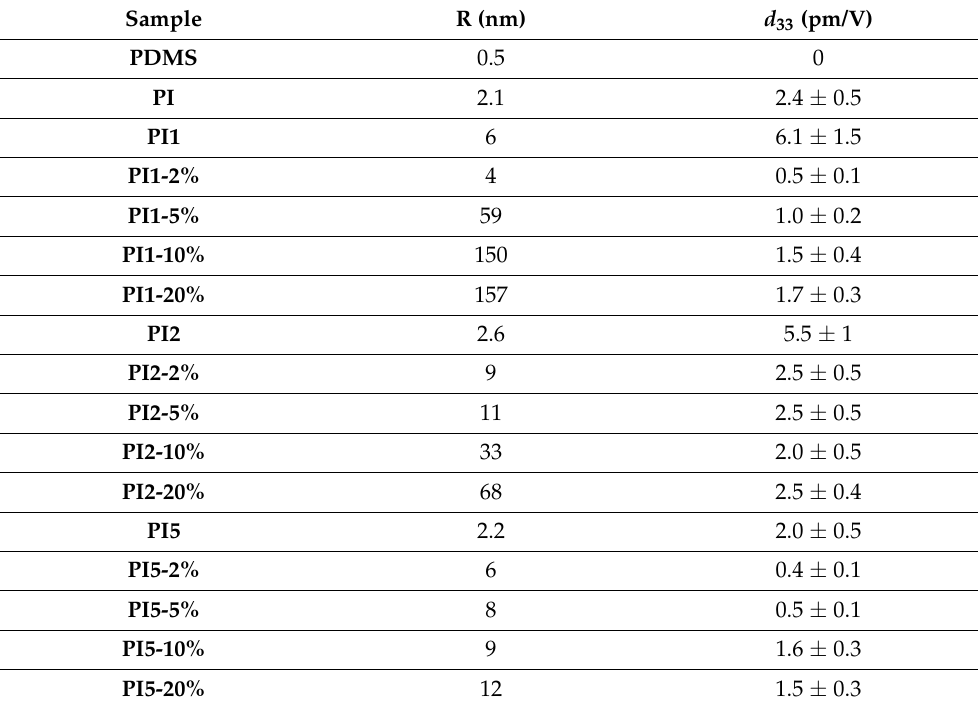
Table 4. Roughness and piezoelectric coefficient for the samples tested.